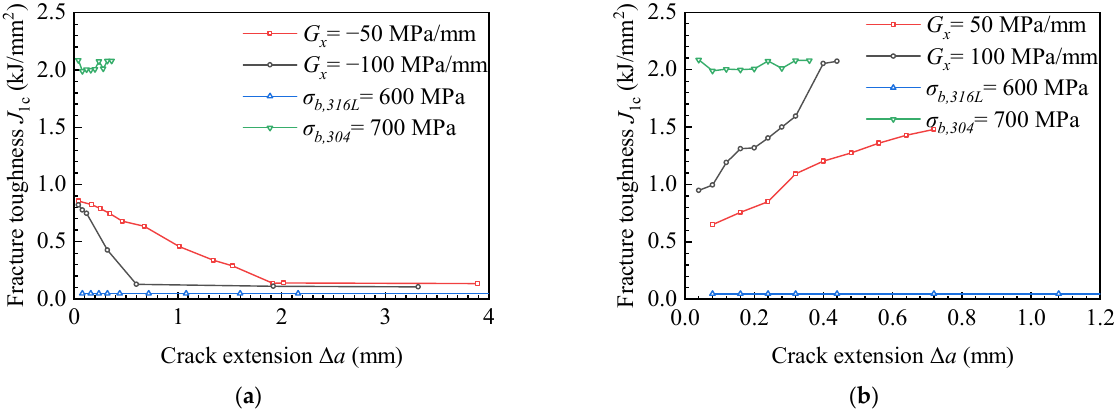
Figure 11. Fracture toughness during crack propagation with different ultimate strength mismatch coefficients in the y ‐ direction. ( a ) G x < 0 and ( b ) G x > 0.